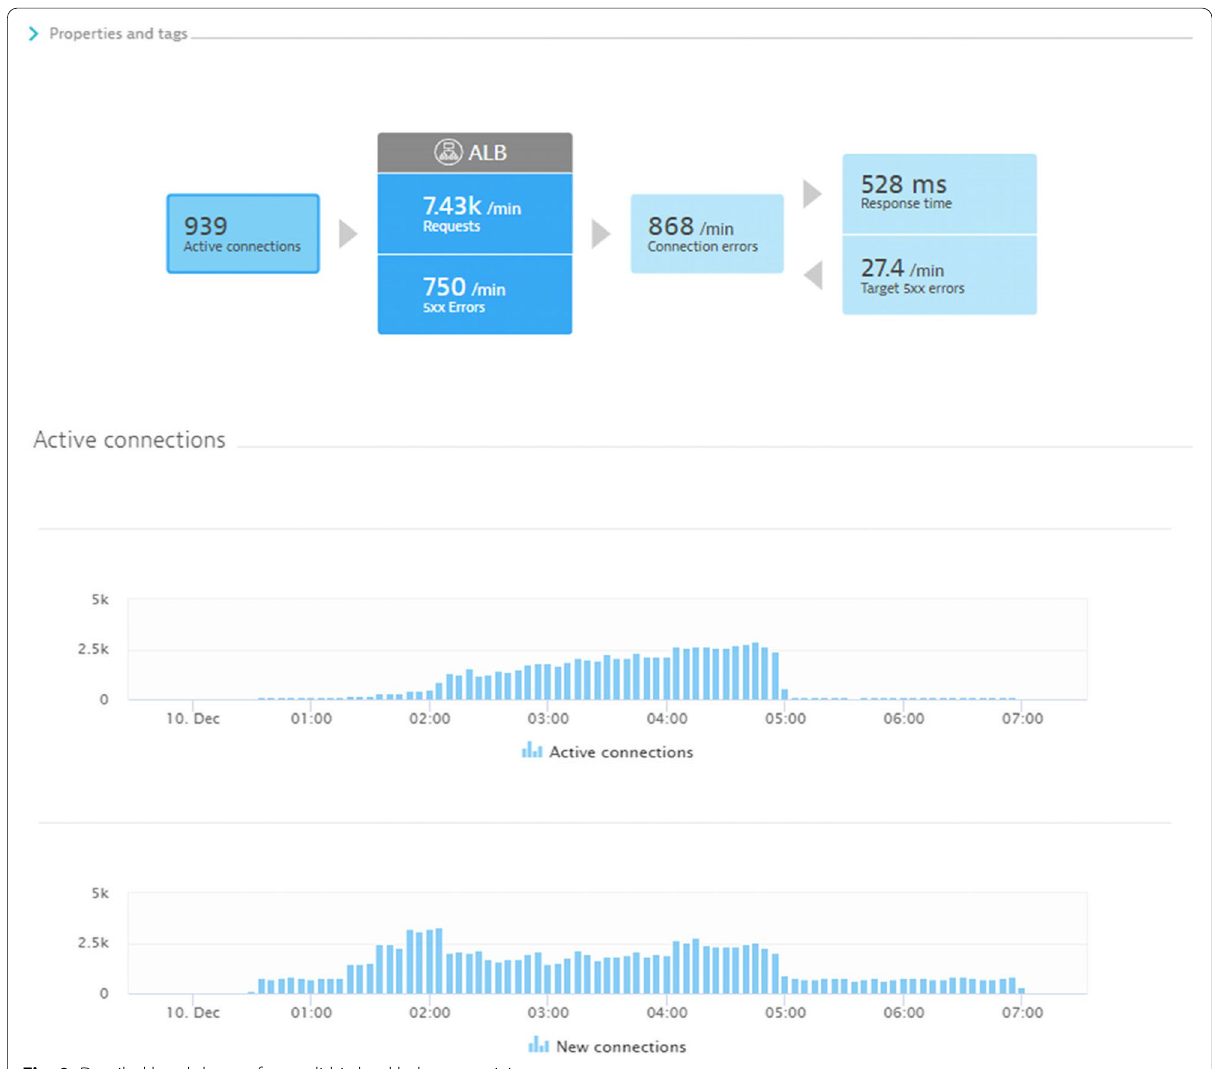
Fig. 9 Detailed breakdown of monolithic load balancer